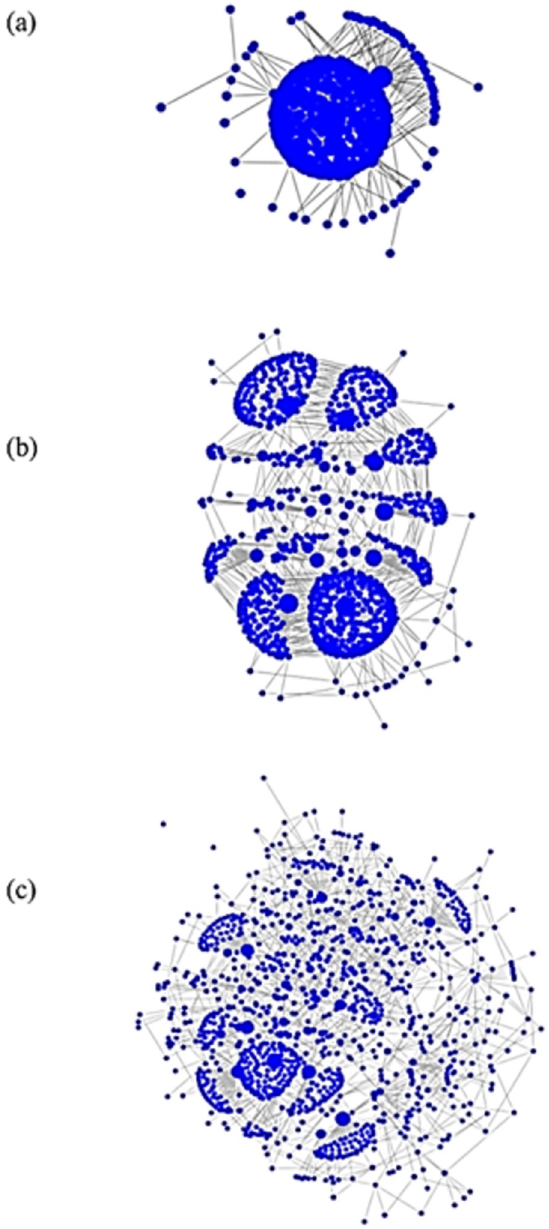
Fig 4. K-step networks of HCV HVR1 sequences from 3 samples. Each node represents a unique haplotype, the diameter of the node is proportional to the haplotype frequency and links between adjacent nodes belong to the union of all minimum spanning trees (a) Low diversity intra-host HCV HVR1 population from PK-9 (0.00512), genotype 3a; (b) average diversity population from PK-20 (0.0142), genotype 1b; (c) high diversity population from PK-23 (0.0226), genotype